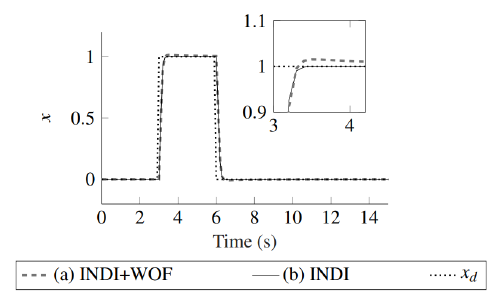
Figure 9. Numerical example: comparison of tracking performance between INDI+WOF and INDI